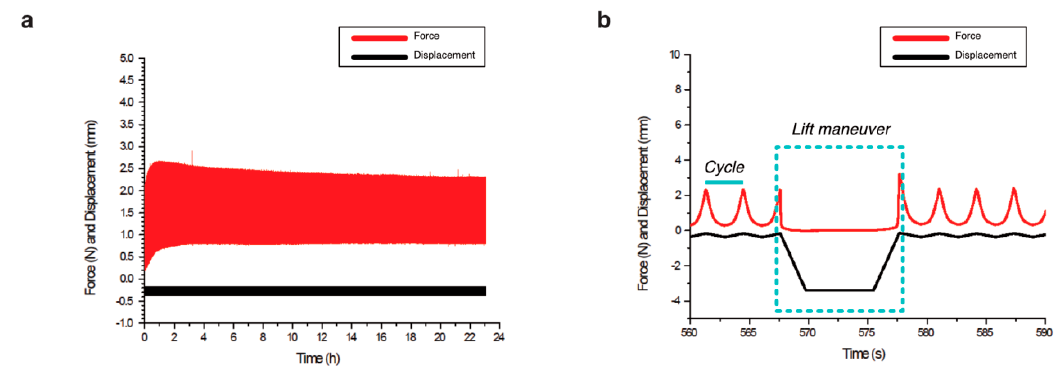
Figure 3. Biomechanical stimulation provided by the compression bioreactor. ( a ) Overview of a complete examination with the displacements of the piston seen in black and the resulting force in red. ( b ) Lift maneuver, i.e., the unloaded phase as part of the intermittent dynamic mechanical loading is shown in detail. Dynamic loading of repetitive cycles that compress and decompress the sca ff olds was applied by the piston for 10 min. Then, an unloaded phase is reached (lift maneuver), in which the piston releases the sca ff old for 10 s. Table 1. Descriptive statistics of the biomechanical stimulation applied on the sca ff olds. Several parameters as displacement of the piston, force, time and number of periods were analyzed for the examinations. n: number of examinations executed in the bioreactor. Sca ff old Data n Mean